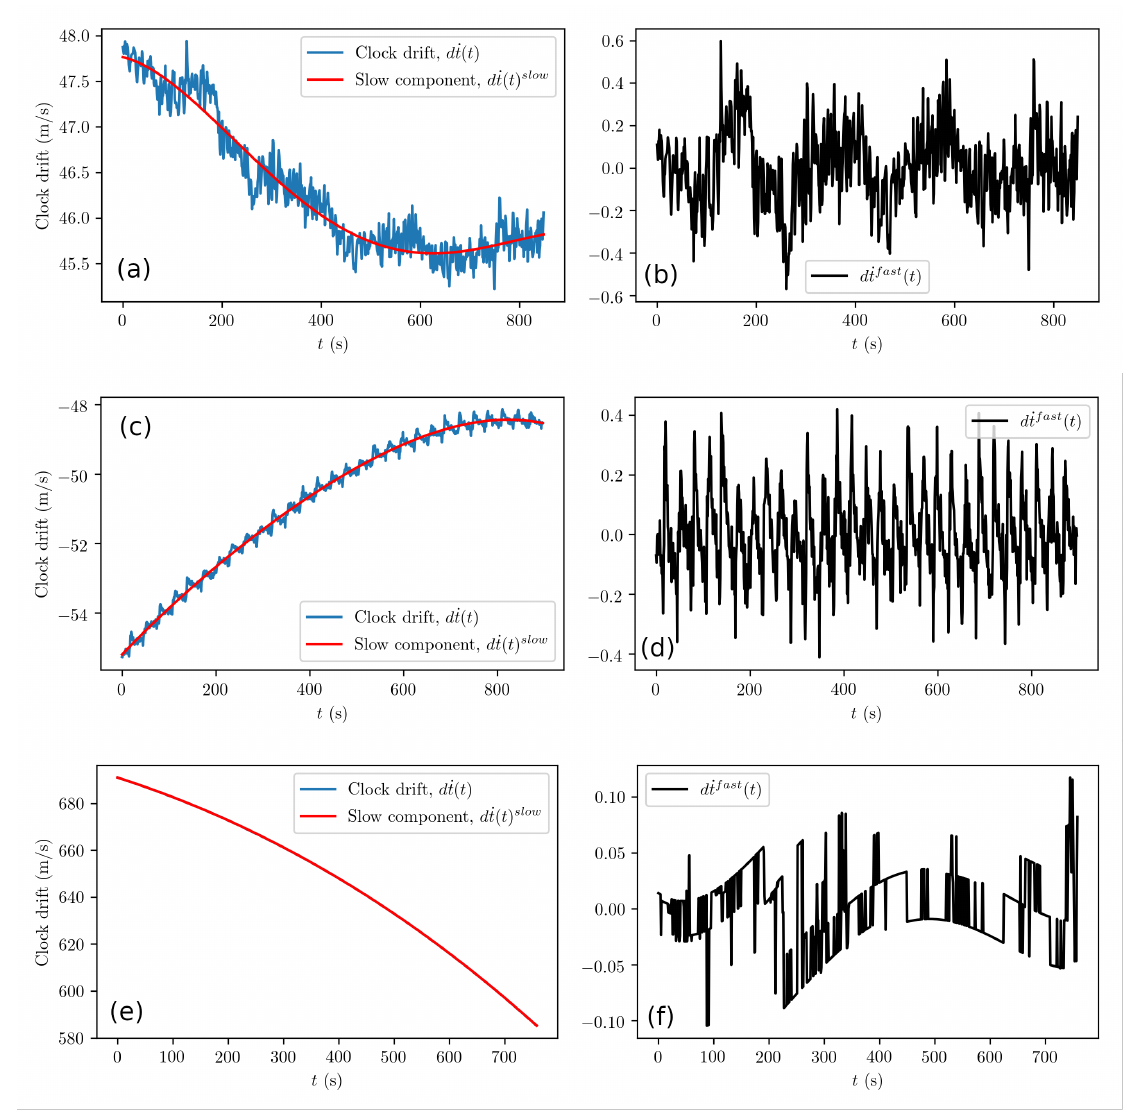
Figure 3. Open sky results for the (low-grade) Samsung S8 smartphone receiver ( a , b ), the (medium-grade) u-blox receiver connected to the patch antenna ( c , d ) and from the (high-grade) Septentrio receiver connected to the Leica antenna ( e , f ). In ( e ), clock drift d ˙ t and slow component lines overlap because the fast component d ˙ t fast = d ˙ t − d ˙ t slow shown in ( f ) is very small. Note that the saw-edge lines in ( f ) are due to the self-correcting behavior of the (high-grade) Septentrio